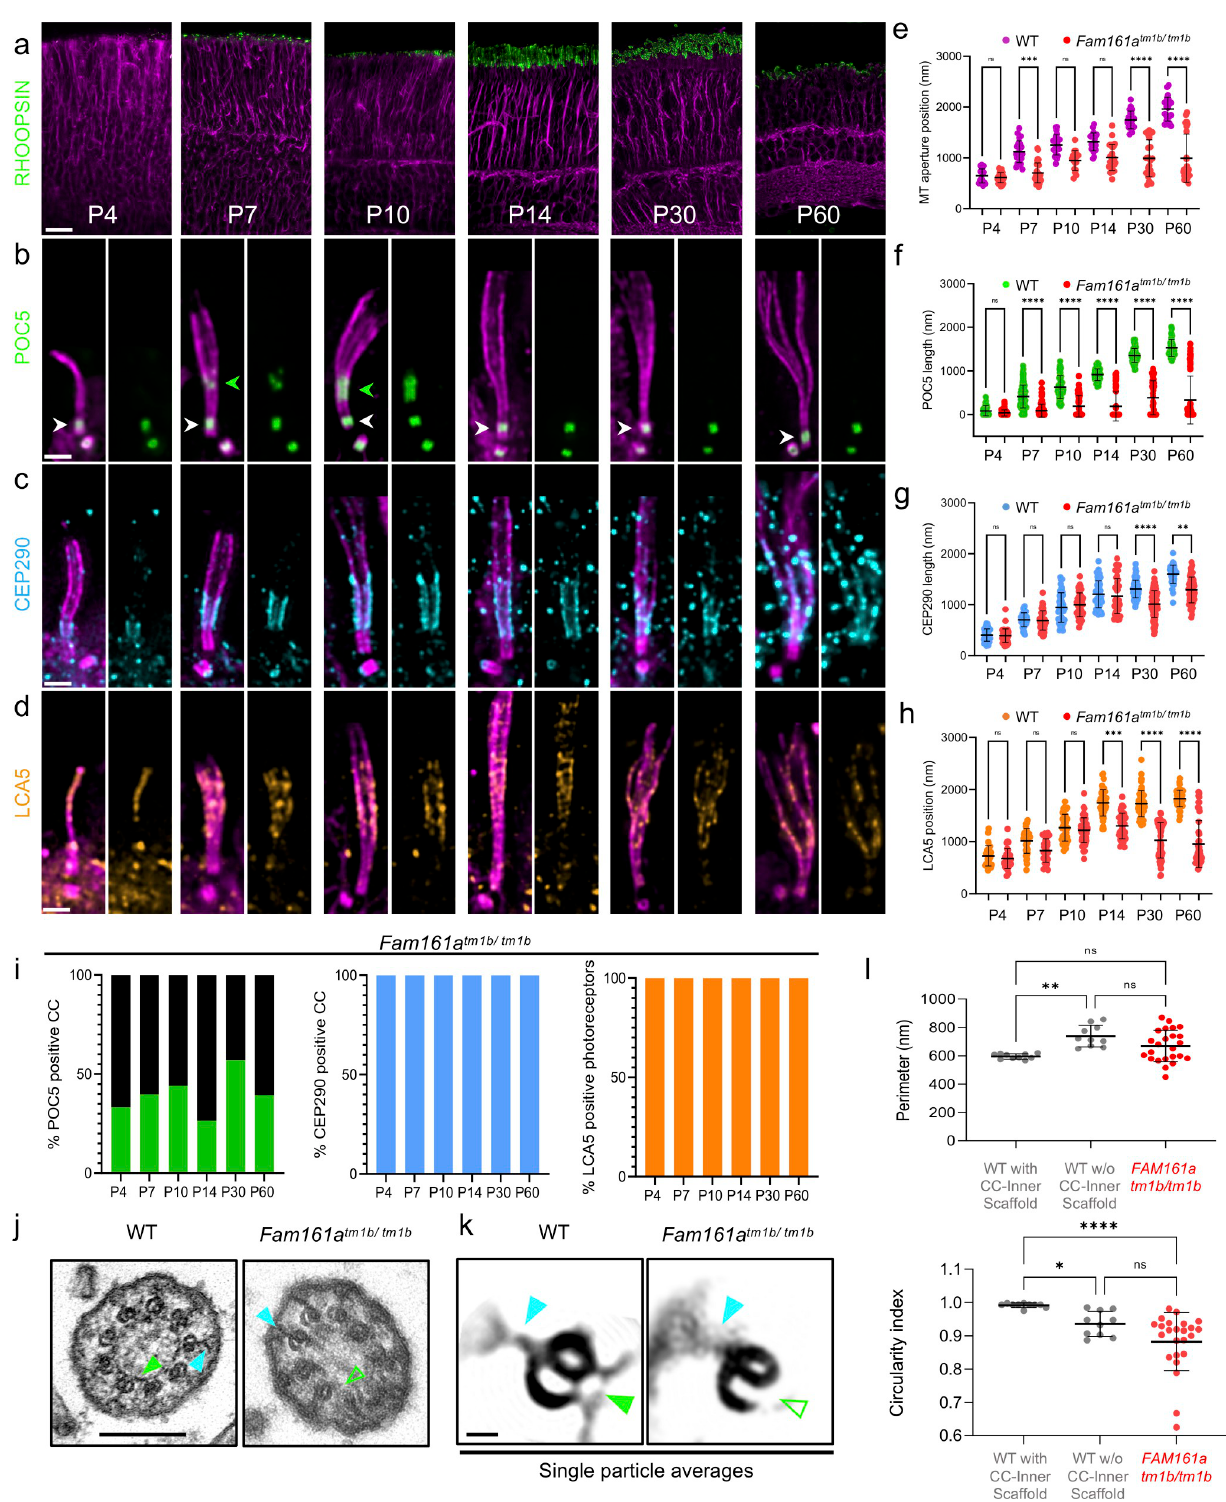
Fig 4. Fam161a mutation leads to the specific loss of the CC inner scaffold. ( a ) Low magnification of expanded Fam161a tm1b/tm1b retinas stained for RHODOPSIN (green) and tubulin (magenta) from P4 to P60. Scale bar: 20 μ m. ( b–d ) Expanded Fam161a tm1b/tm1b photoreceptors stained for POC5 (green, b), CEP290 (cyan, c), and LCA5 (orange, d) from P4 to P60. Note the transitory appearance of the CC inner scaffold between P7 and P10 (green arrowheads) followed by its collapse, paralleling microtubule spread. In contrast, centriole inner scaffold (white arrowheads) is retained over time.